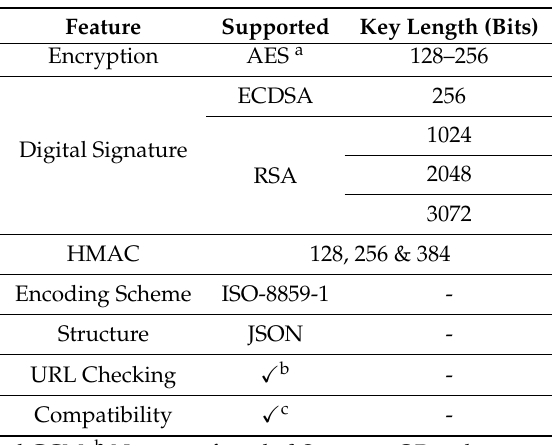
Table 6. BarSec Droid